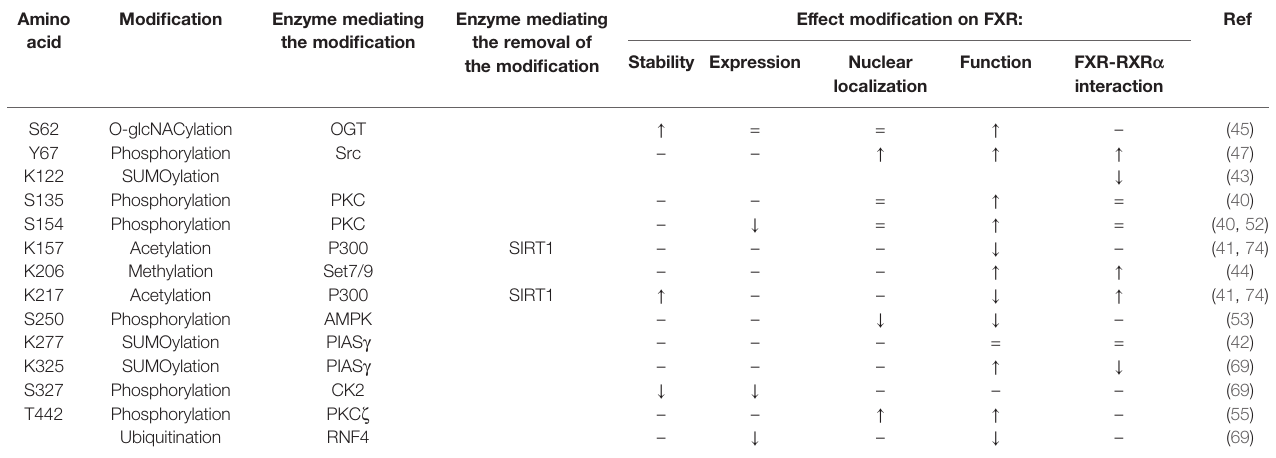
TABLE 1 | FXR modi fi cations and their effects on FXR function. Amino acid